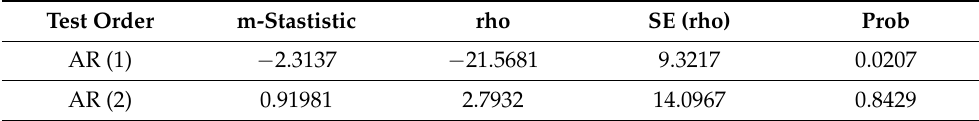
Table 6. Arrellano–Bond serial correlation